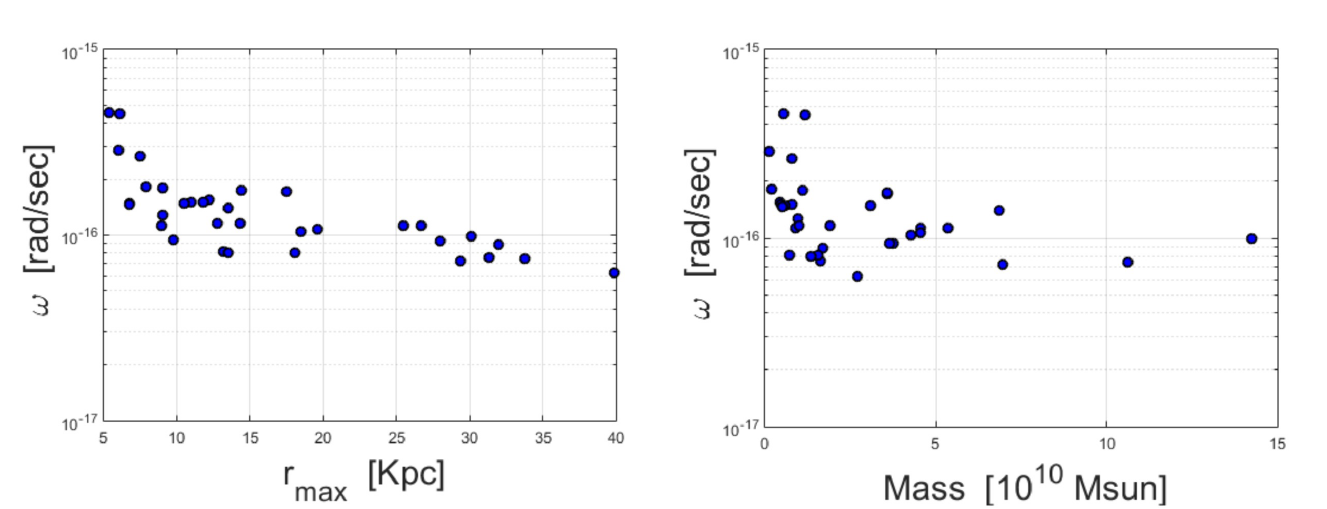
Figure 5. Left panel: a scatter plot of the best-fitted ω ’s vs. r max (the last point of the RC). Right Panel: a scatter plot of ω vs. the galaxy’s mass. Both plots were produced using the sample of galaxies summarized in Appendix